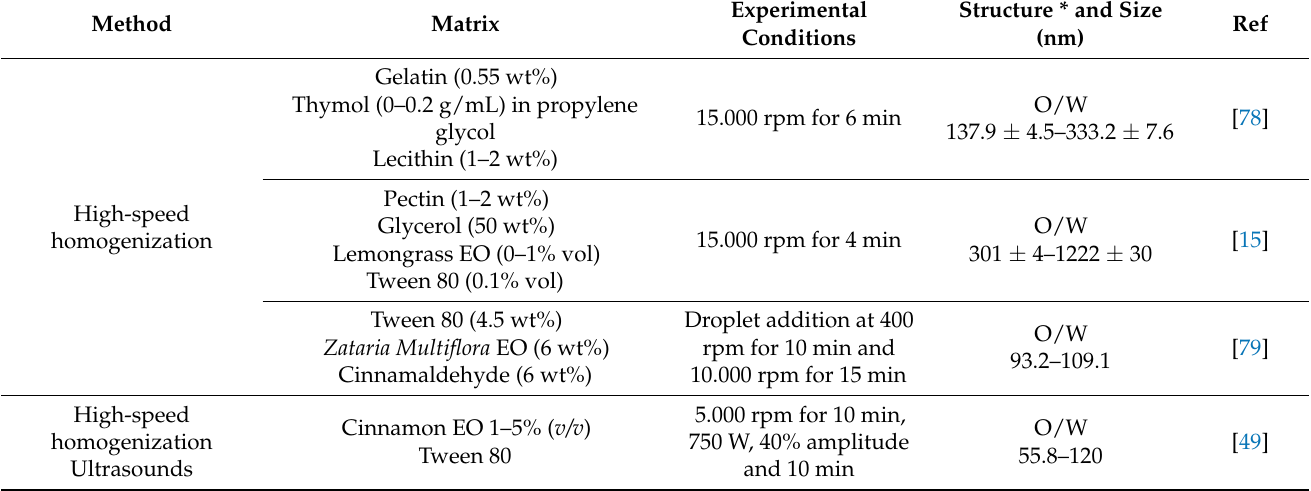
Table 2. Several methods, experimental conditions, and matrix to obtain